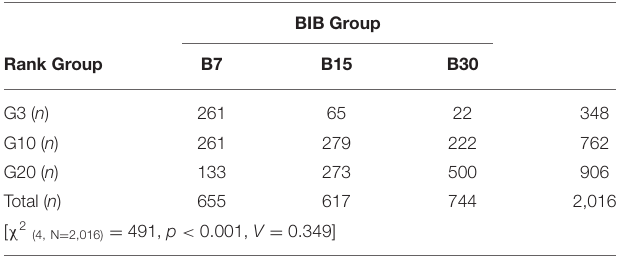
TABLE 3 | Number of placings for different starting groups in women’s FIS World Cup Giant Slalom